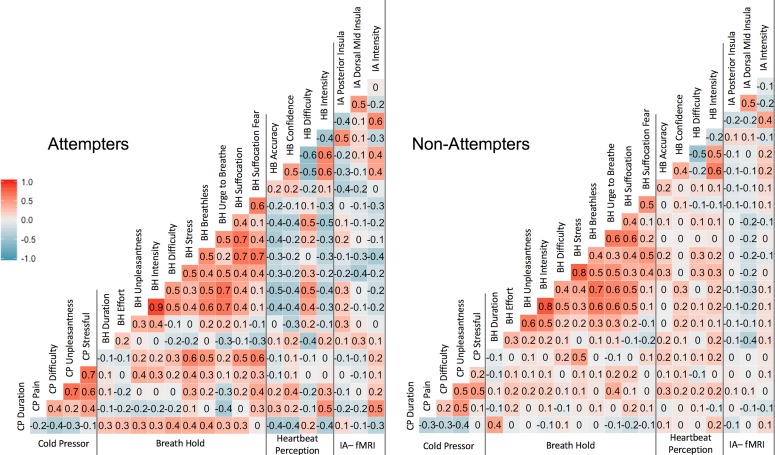
Pearson correlation coefficients across measures.‘CP’ = cold-pressor, ‘BH’ = breath-hold (computed using participants’ mean duration and VAS ratings across trial 1 and trial 2, ‘HB’ = heartbeat perception task (computed using the mean of the no-guess and perturbation conditions). IA-fMRI = interoceptive attention to heartbeat sensations during fMRI.